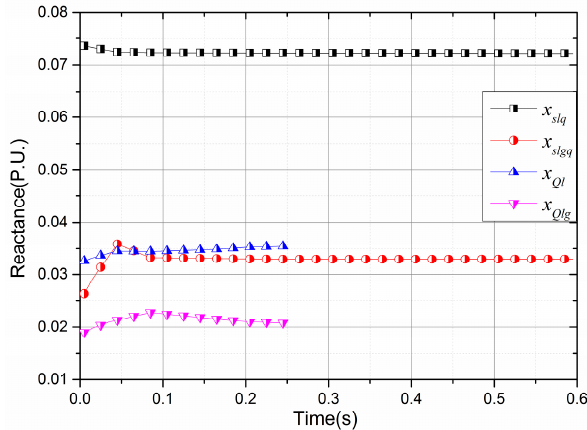
Figure 11. Variation in the q -axis leakage inductances during the transient process. Energies 2017 , 10 , 1015 14 of 18